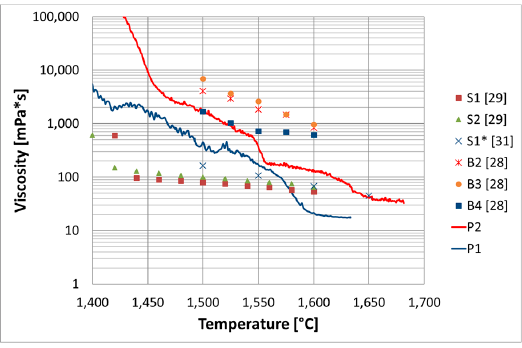
Figure 2. Comparison of measured viscosity with literature values from [28,29,31].